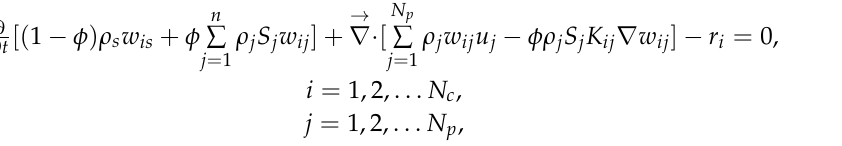
Figure 4. Comparisons of oil recovery between lab data and huff-‘n-puff simulation.